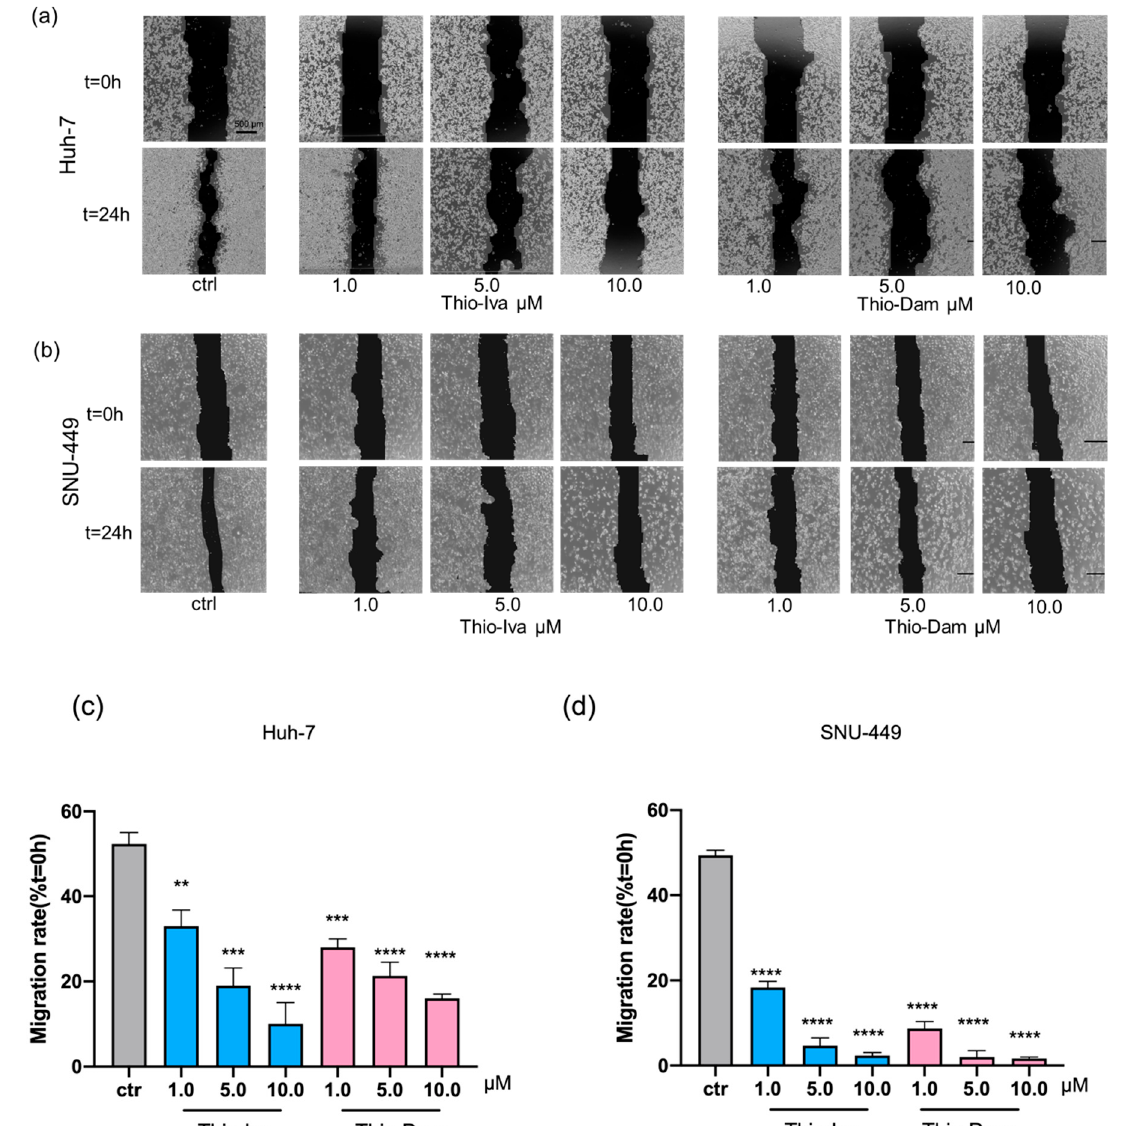
Figure 8. Antimigratory effects of Thio-Iva and Thio-Dam in Huh-7 and SNU-449. ( a ) Representative images of antimigratory effects of Thio-Iva and Thio-Dam (1–10 μ M) in Huh-7 cells after 24 h. ( b ) Representative images of antimigratory effects of Thio-Iva and Thio-Dam in SNU-449 cells after 24 h. ( c , d ) Quantification of the migration rate (in %) of SNU-449 cells after incubation with Thio-Iva and Thio-Dam. ** p < 0.01, *** p < 0.001, and **** p < 0.0001 by ordinary one-way ANOVA compared to untreated controls. Results are given as means ± SEM of = 3 independent experiments. Scale bar, 500 μ m.